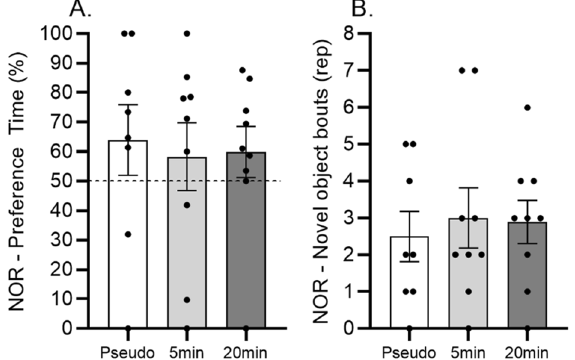
Figure 4. Effects of 5 and 20 min daily sessions of WBV on object memory in the novel object recognition test (NOR). Preference time in % (panel A ) and frequency of novel object exploration (panel B ). One-way ANOVA was used for reveiling the difference between the experimental groups. Further, independent T-test for single sample was used for comparing preference time to the 50% chance level (dashed line). Data are depicted as mean ± SEM. * indicates P <